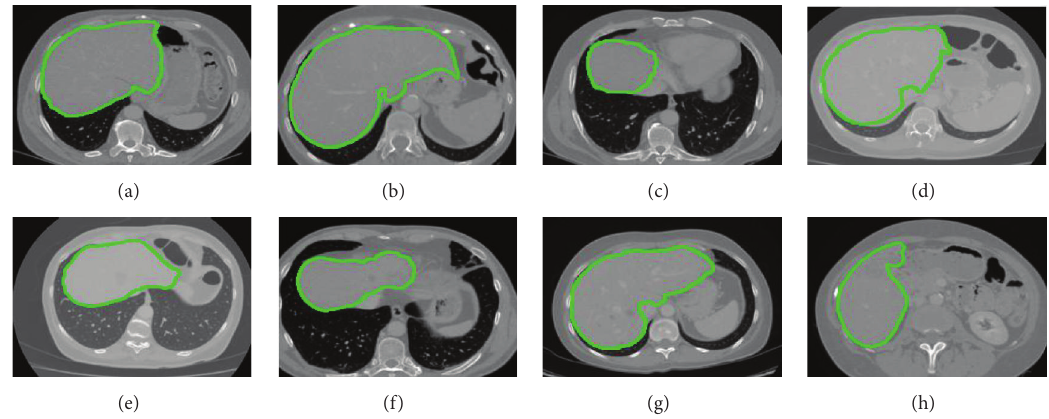
Figure 7: Segmentation results (marked in green) using the proposed method.